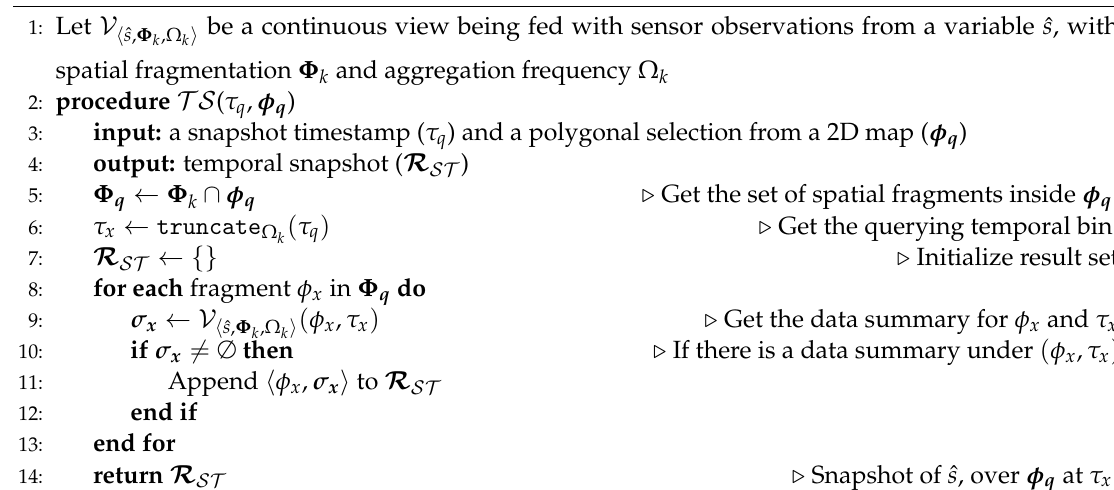
Algorithm 3 E XPLORA query processing for snapshot-temporal queries. spatial fragmentation Φ k and aggregation frequency Ω